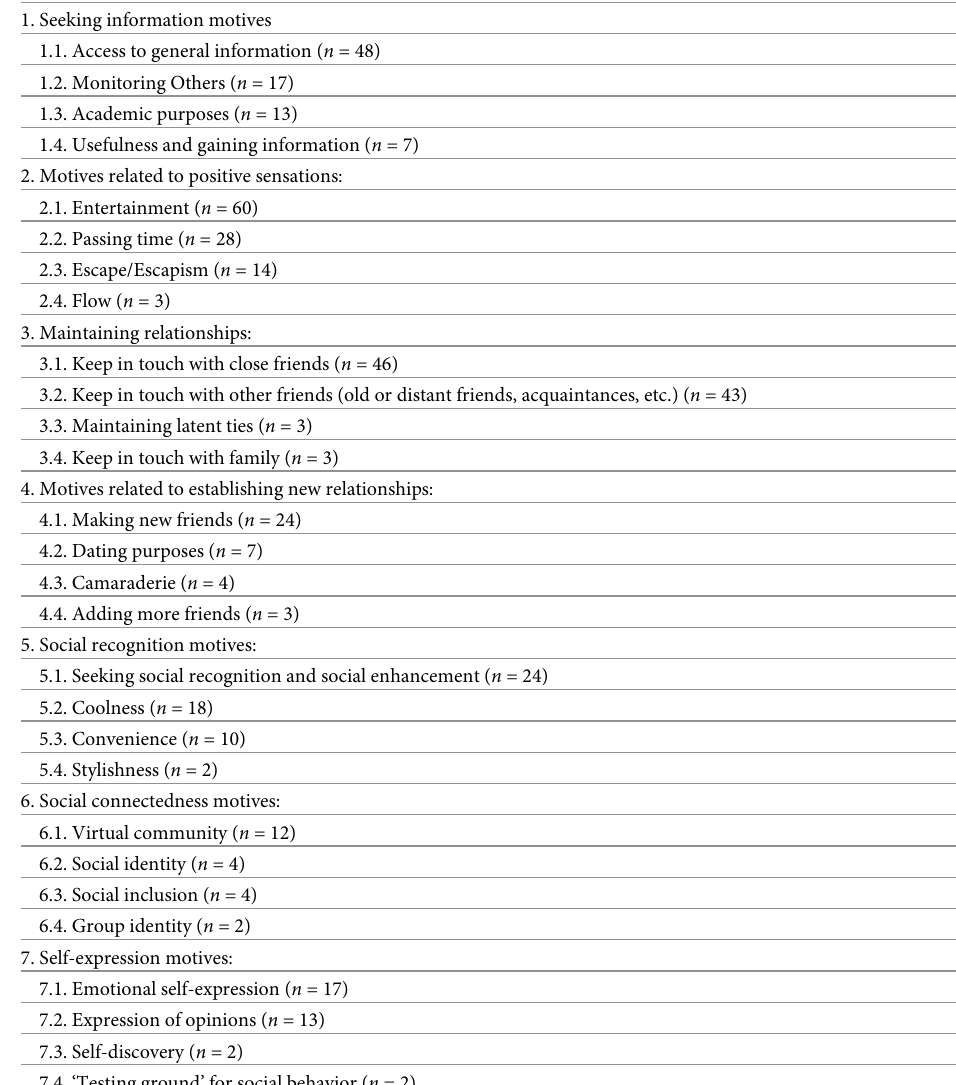
Table 1. Main types of motives for using SNS studied to